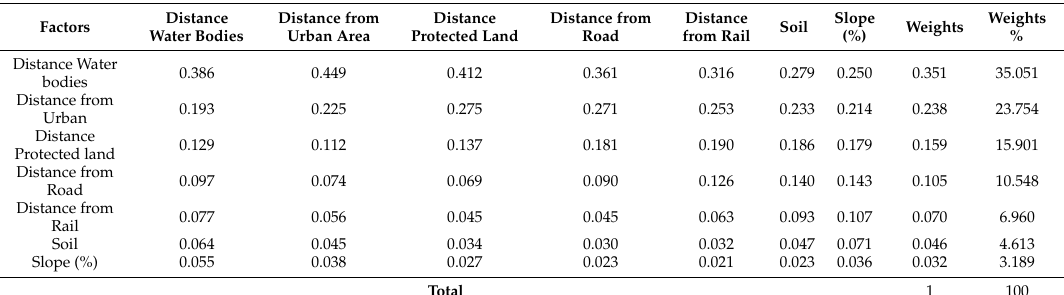
Table 4. Standardization of comparison matrix.